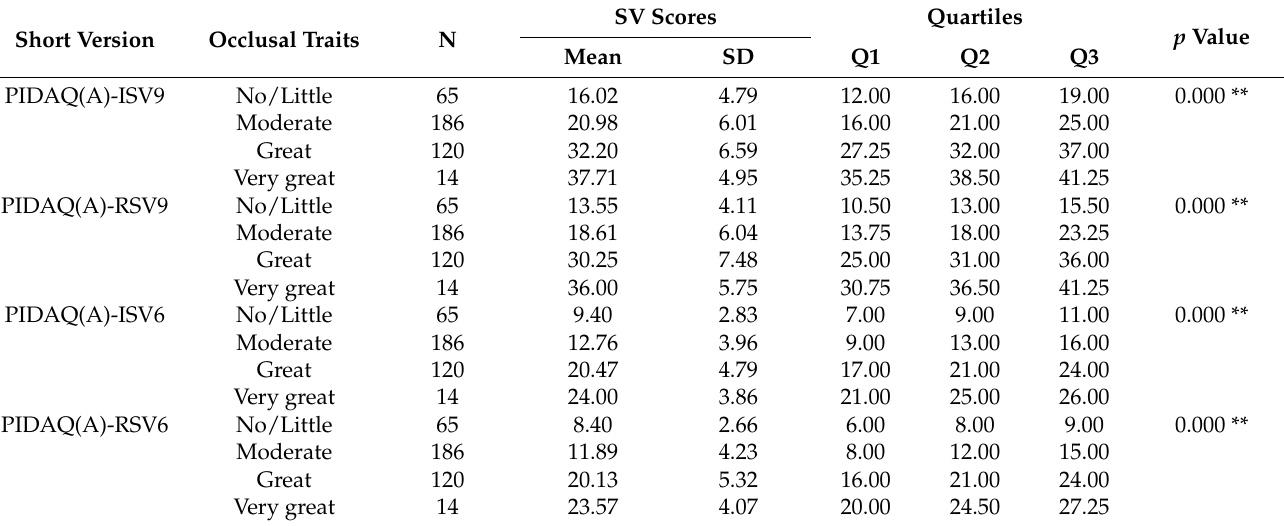
Table 14. The discriminant validity: associations of the short versions with